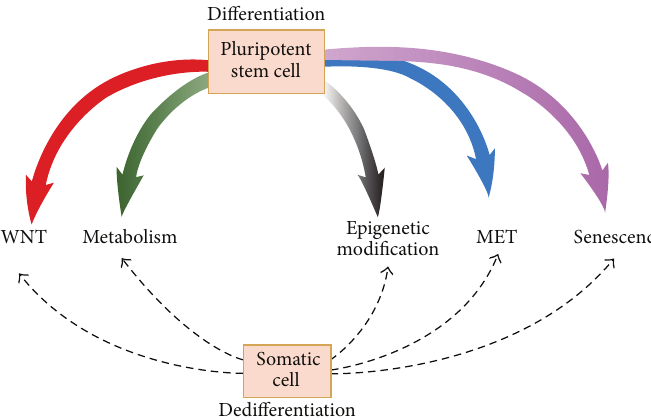
Figure 1: Differentiation and reprogramming are influenced by various mechanisms. Small molecules used to generate iPSCs can be categorized as epigenetic modifiers, WNT signal modulators, cell senescence moderators, modulators of metabolism, and regulators of MET and cell death/senescence pathways. They can influence both differentiation and reprogramming